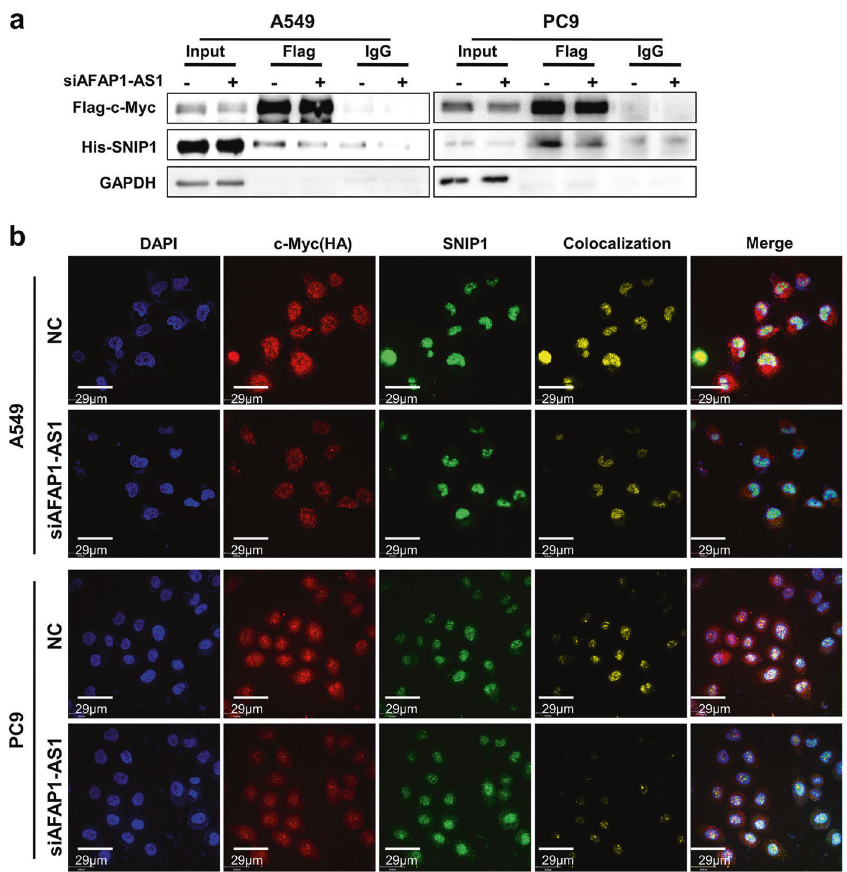
Fig. 7 AFAP1-AS1 mediates the combination of SNIP1 and c-Myc proteins acting as a molecular guide. a Immunoprecipitation showed that the combination of SNIP1 and c-Myc was signi fi cantly weakened during overexpression of His-SNIP1 and Flag-c-Myc in A549 and PC9 cell lines knocked down for AFAP1-AS1. b Immuno fl uorescence of c-Myc and SNIP1 in A549 and PC9 cells after overexpression of His-SNIP1 and HA-c- Myc and knockdown of AFAP1-AS1. AFAP1-AS1 knockdown weakened the colocalization of SNIP1 and c-Myc proteins in A549 and PC9 cells. DAPI-stained nucleus: blue; anti-HA (c-Myc): red; anti-SNIP1: green; colocalization of c-Myc and SNIP1: yellow; the merged image represents the overlap of DAPI, c-Myc, and SNIP1 (Scale bar: 29 μ